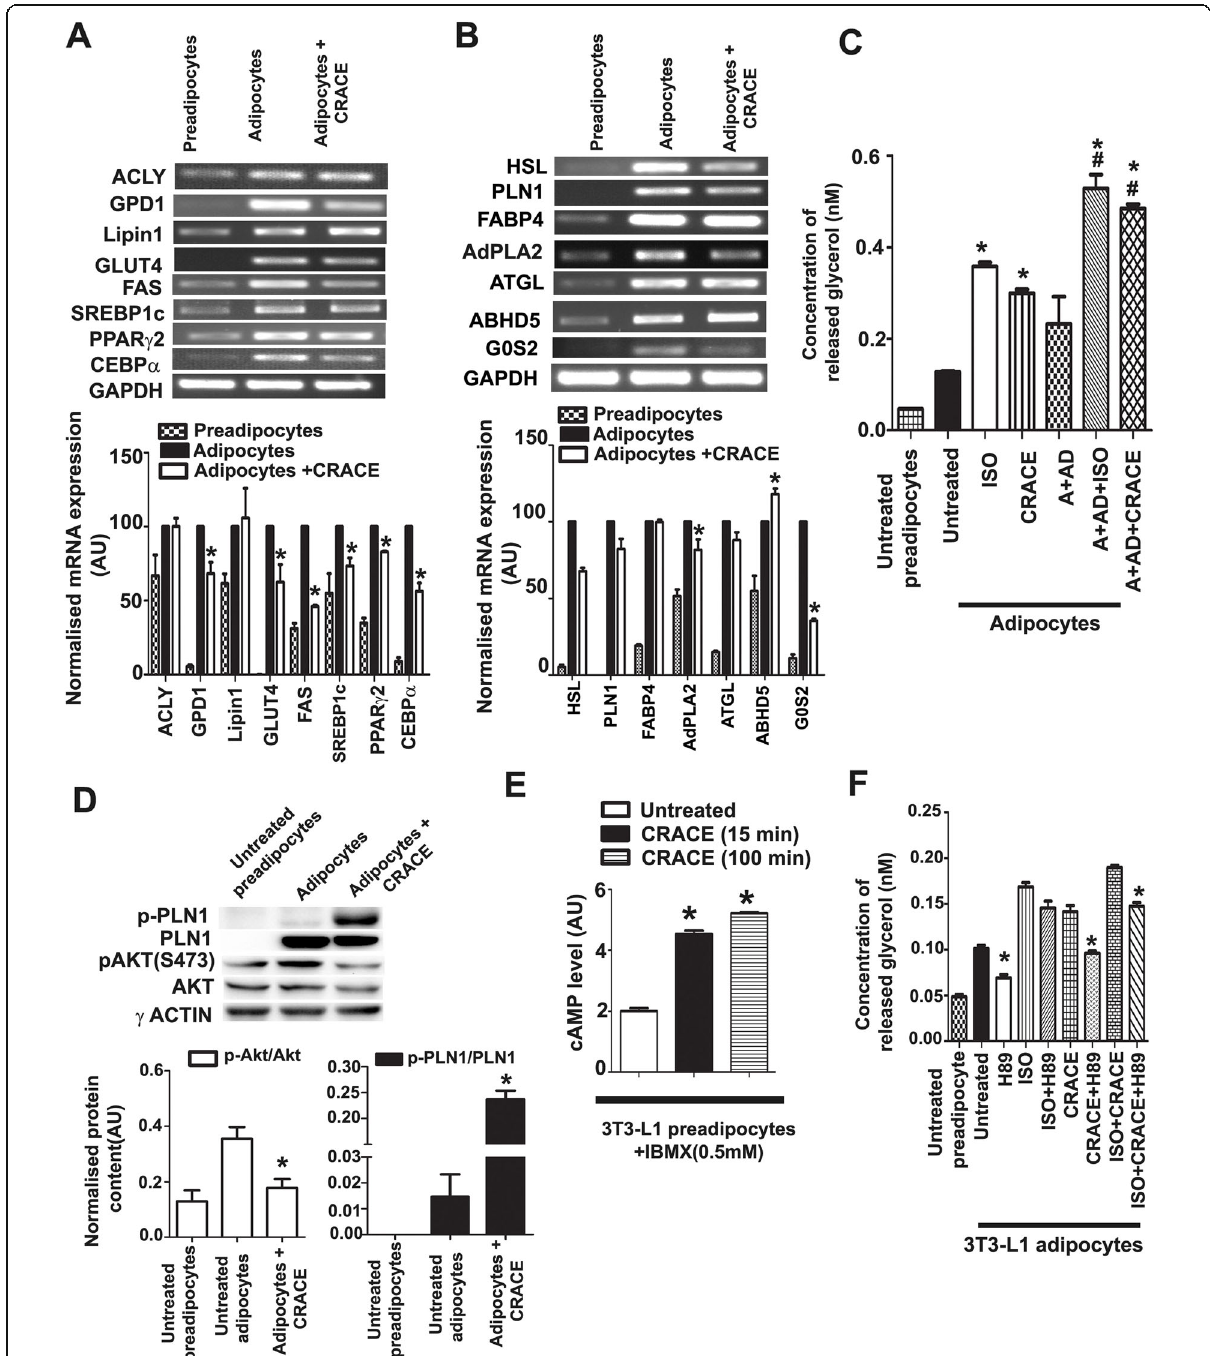
Fig. 4 (See legend on next